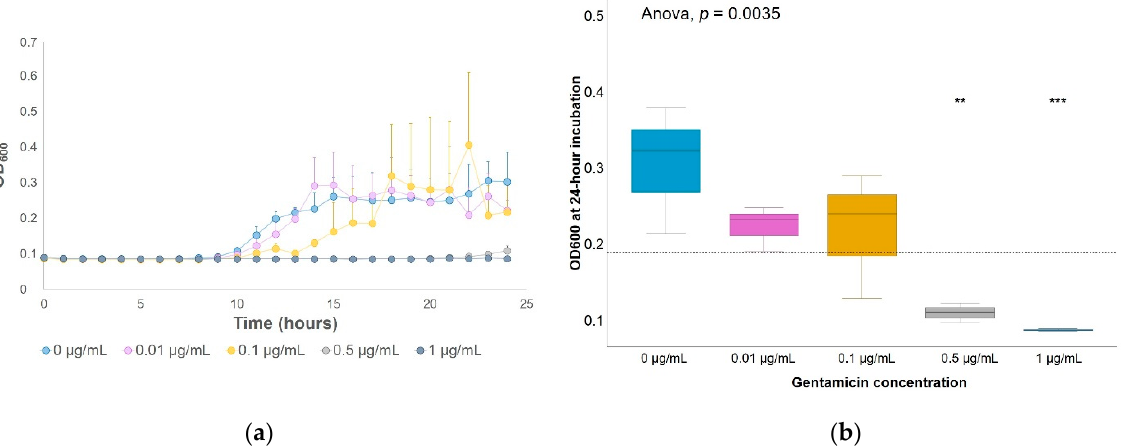
Figure 1. Gentamicin growth inhibition on soil bacterial enrichments. Optical density measured at 600 nm (OD 600 ) of cultivable soil bacteria incubated in 1:10 tryptic soy broth (TSB) with different gentamicin concentrations: ( a ) for every hour during a 24-h incubation at 29 °C; ( b ) after 24-h incubation. Significant differences between each group (each gentamicin concentration) and the average between all groups (horizontal dashed line) were determined by a t-test. ** p -value ≤ 0.01; *** p -value ≤ 0.001. n = 3.